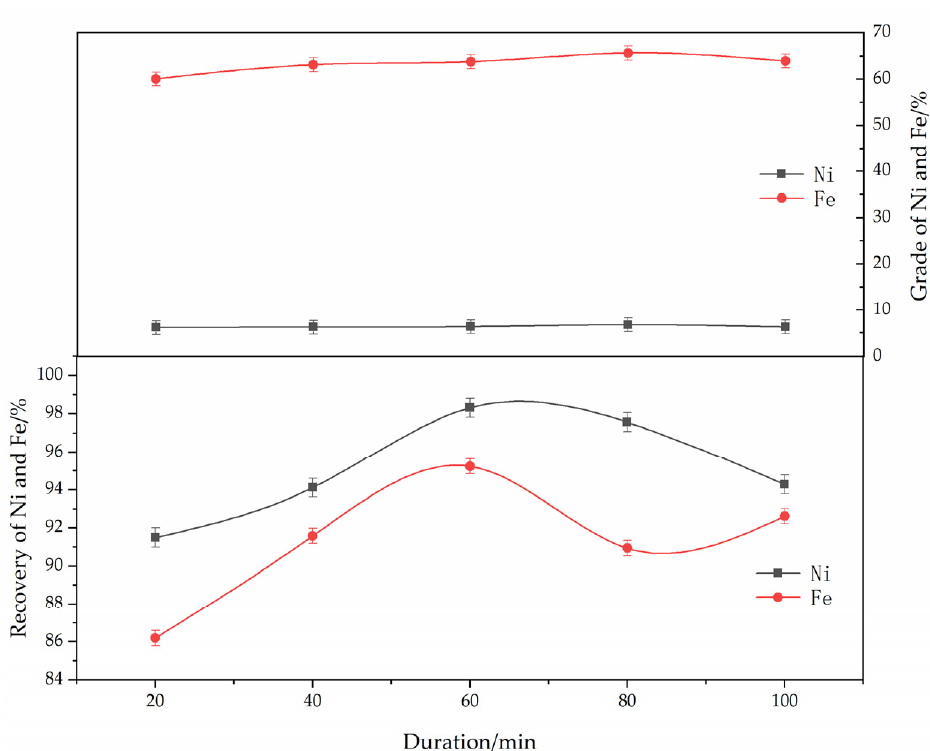
Figure 7. The effect of roasting duration on the grade and recovery of nickel-iron in ferronickel concentrate. (The ferronickel concentrate dosage was 30 wt. %, The reducing temperature was 1250 ◦ C, the reductant dosage was 8 wt. %, the magnetic separation was 150 mT). The effect of reductant dosage on the reduction and magnetic separation of low-grade nickel laterite ore is shown in Figure 8. The experimental conditions were determined as follows: ferronickel concentrate dosage of 30%, reduction temperature of 1250 ◦ C, roasting time of 60 min, calcium fluoride content of 7%, magnetic separation intensity of 150 mT. As can be seen from Figure 8, with the increase of reductant dosage, the grade of nickel in ferronickel-concentrate first increased and then decreased, while the grade of iron increased. When reductant dosage increased from 4% to 10%, the nickel grade increased from 5.66% to 7.45%, and the recovery efficiency of nickel increased from 67.0% to 96.3%. However, when the reductant dosage increased to 12%, the grade of the nickel decreased to 6.44%, and the recovery efficiency of nickel was 90.5%. Increasing the reductant dosage can reduce the metal oxides, but excessive residual anthracite will increase the amount of residual carbon, and produce more ash, which leads to the difficulty of migration and aggregation of ferronickel after reduction. Therefore, the smaller ferronickel particles are wrapped by impurities and cannot be separated effectively by magnetic separation. In addition, a large amount of iron oxide becomes reduced to the concentrate. Excessive residual anthracite causes the decrease of the nickel grade in concentrate, therefore the optimum amount of reductant is